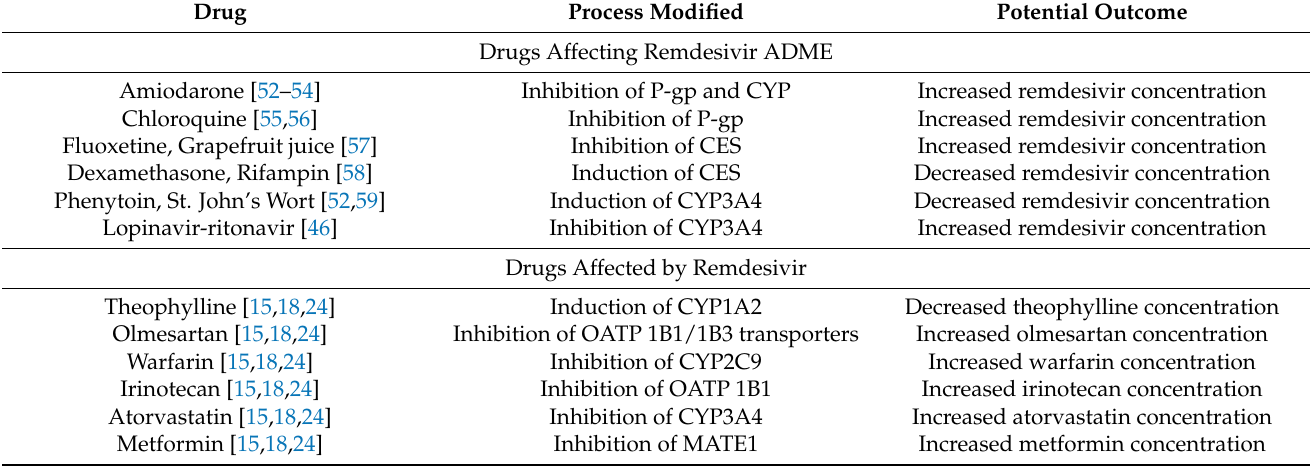
Table 2. Potential drug-drug interactions of remdesivir with COVID-19 treatment regimens and with drugs for comorbidities.